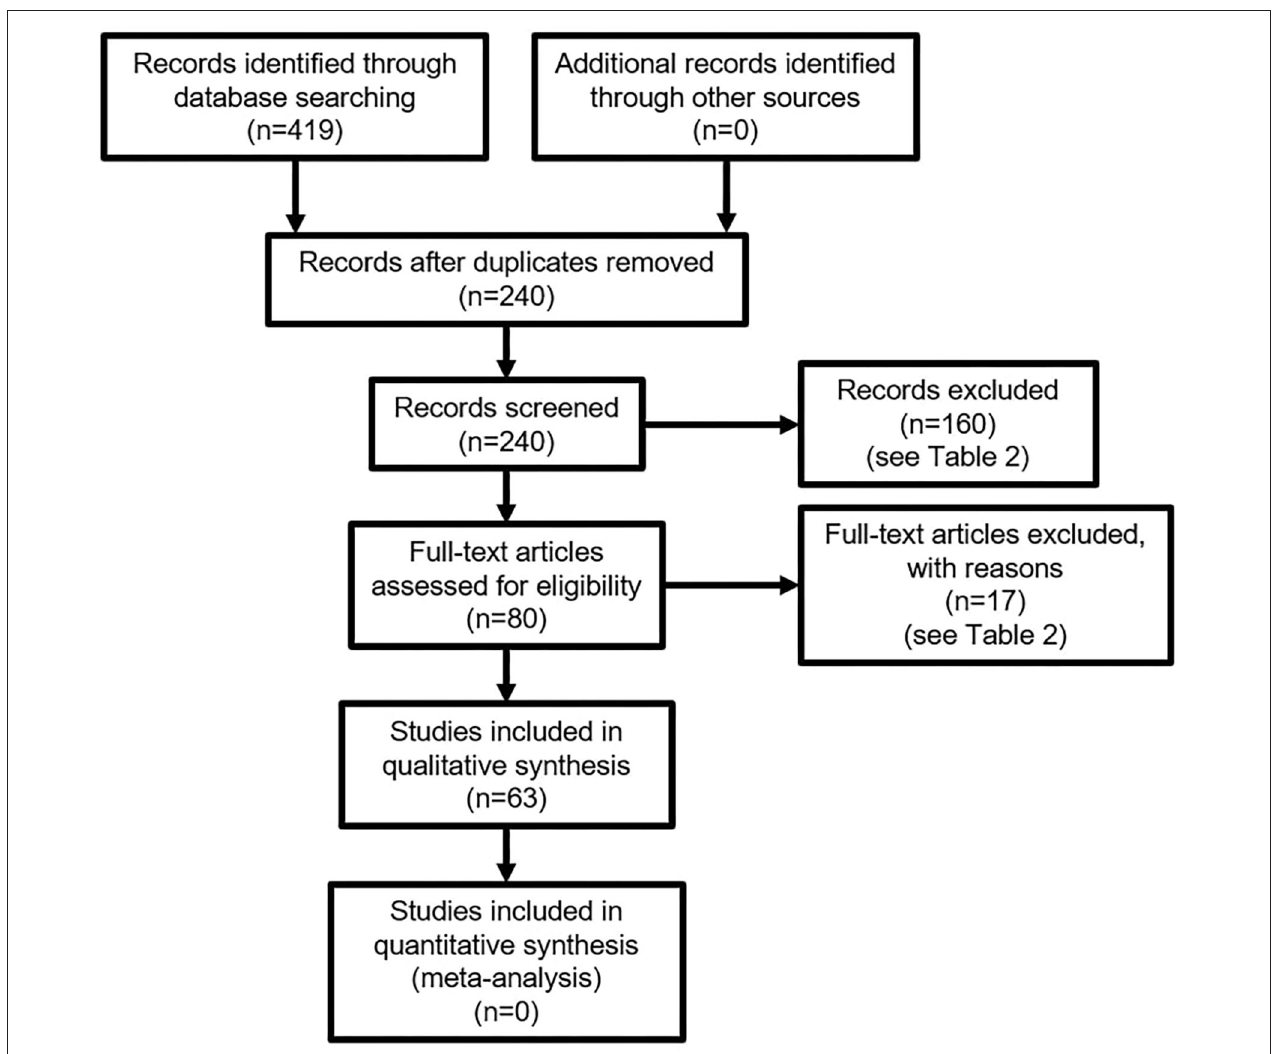
FIGURE 1 | PRISMA Flow